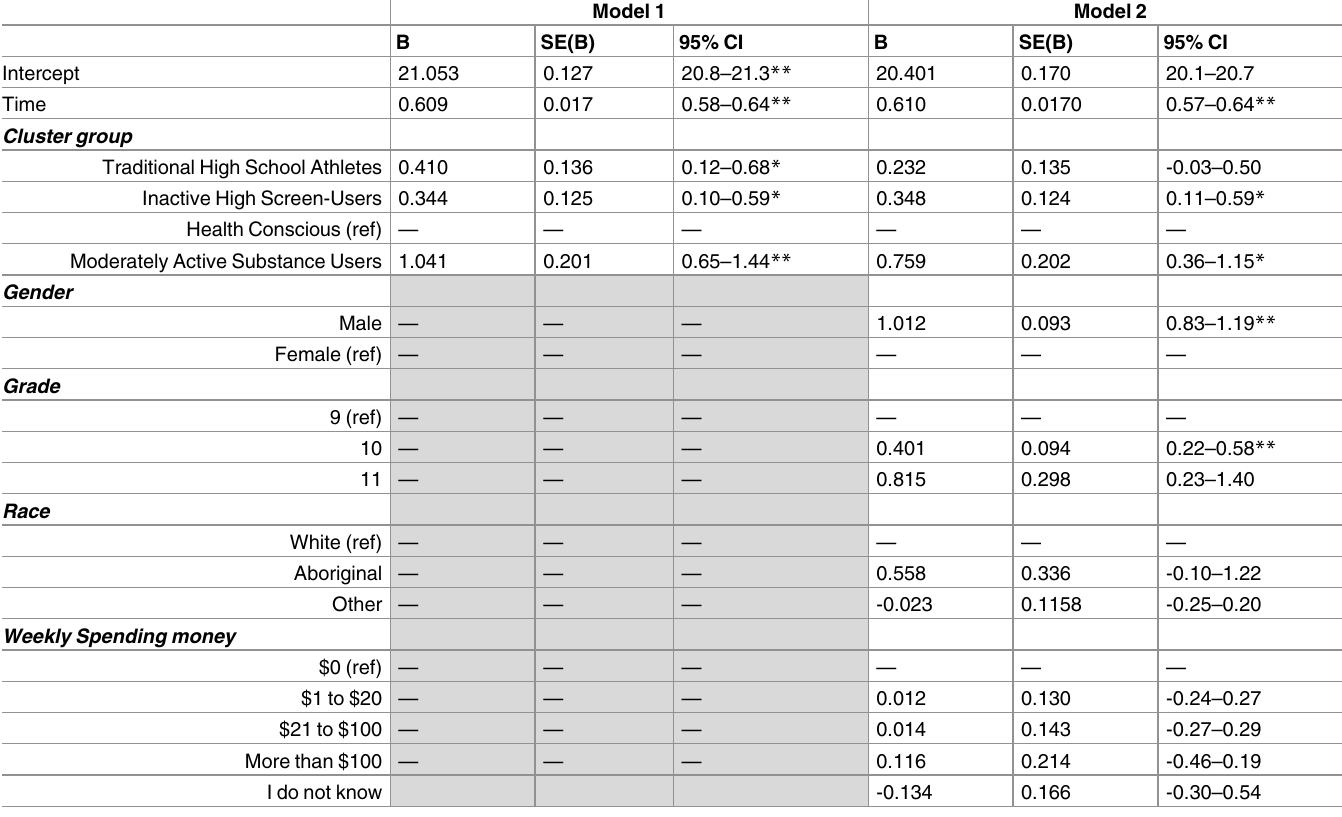
Table 3. Regression coefficients for the relationship between risky behavioural clusters at baseline and BMI over time among youth participating in Y 1 to Y 3 of the COMPASS study in Ontario, Canada